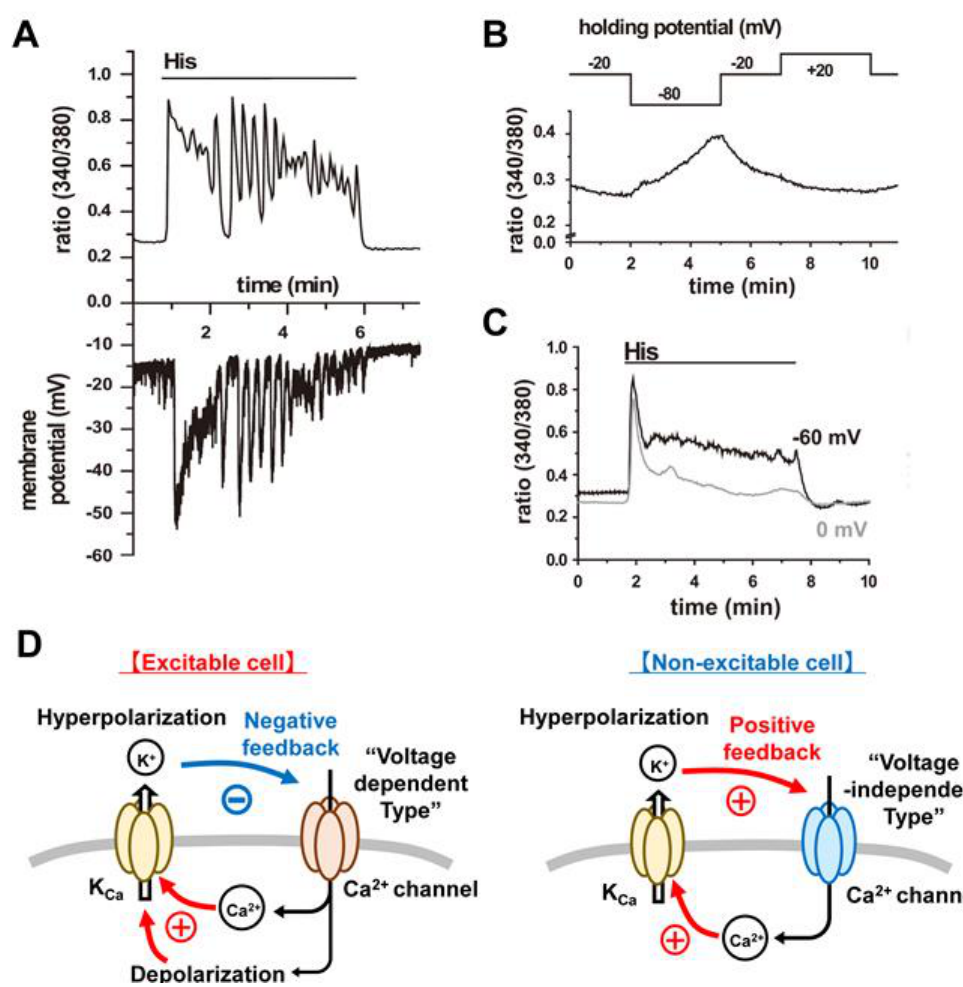
Figure 3. Relationship between change in membrane potential and [Ca 2 + ] i . ( A ) Whole cell patch techniques were applied to OUMS-27 cells loaded with fura-2 from recording pipette. Typical simultaneous recording of [Ca 2 + ] i signals (top) and membrane potential (bottom) under current-clamp mode. ( B ) [Ca 2 + ] i signals were measured during voltage-clamp protocols in the absence of 1 µ M histamine. ( C ) the black and gray lines indicate changes in [Ca 2 + ] i measured in the presence of 1 µ M histamine at holding potential of − 60 and 0 mV, respectively. These data clearly showed that membrane hyperpolarization increases Ca 2 + influx through voltage-independent Ca 2 + channel (VICC). Figure 3A–C were obtained from Ref [17]. ( D ) diagram of relationship between change in membrane potential and [Ca 2 + ] i in excitable and non-excitable cells. (Left) In excitable cells, depolarization opens voltage-dependent Ca 2 + channels (VDCC), which causes Ca 2 + influx as well as further depolarization. In these cells, K Ca channel, especially BK Ca channel, is activated, and subsequently causes hyperpolarization. This hyperpolarization decreases Ca 2 + influx through VDCC. Thus, BK Ca channel functions as negative feedback to VDCC activity. (Right) In non-excitable cells, VICC, not VDCC, is main Ca 2 + channel. CRAC channel is a representative VICC and activates K Ca channel, which results in hyperpolarization. The gating of CRAC channel is not closed by hyperpolarization because CRAC channel does not have voltage-sensing domain. As long as STIM opens the pore of CRAC channel, CRAC can conduct Ca 2 + even at the hyperpolarized potentials. Hyperpolarization caused by K Ca channel increases driving force for Ca 2 + and thus promotes Ca 2 + influx through CRAC channel. Therefore, BK Ca channels contribute to positive feedback for Ca 2 + influx through CRAC channels. Note that CRAC channel activation causes very small membrane depolarization because their single channel conductance (9 fS [29]) is much smaller than that of VDCC (L-type Cav1.2 channel: 2.4 pS [30]). Therefore, quite small depolarization by Ca 2 + influx through CRAC channels is lost because of large membrane hyperpolarization caused by K + conductance through BK Ca channel (200 pS